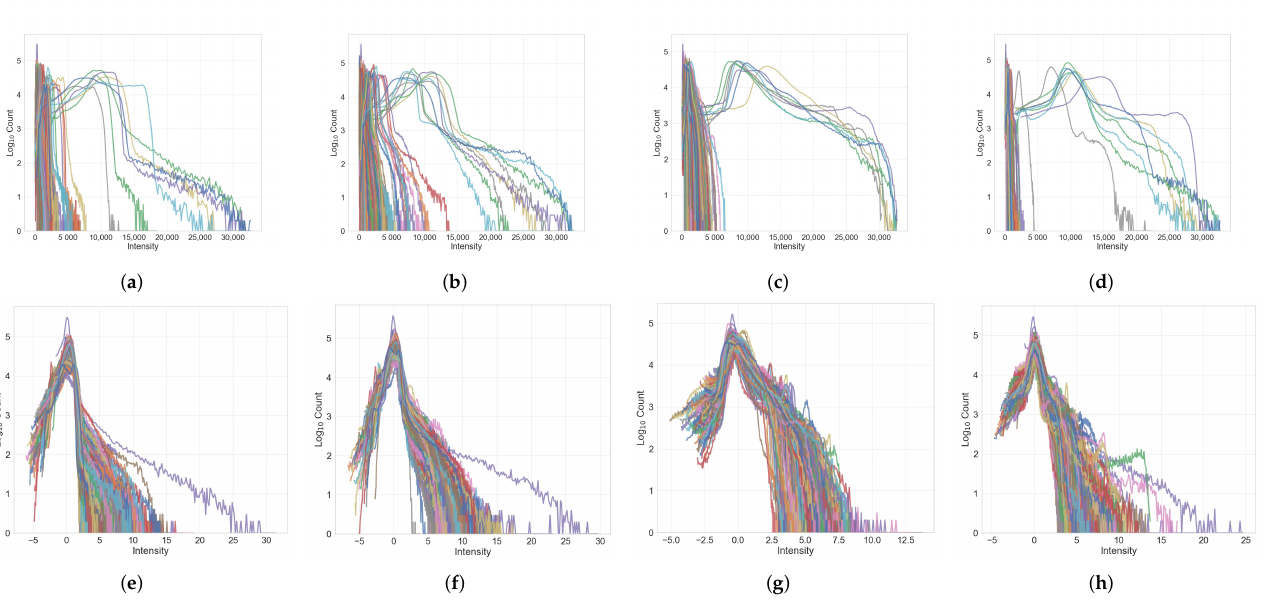
Figure A1. The intensity histograms of the original images (first row) and the Z-score normalized images (second row) for the four sequences of the MRI images. Each colored line corresponds to an image histogram of one preprocessed brain MRI image downloaded from the TCGA-GBM or TCGA- LGG dataset. The subfigures correspond to the image histograms of ( a ) original T1 MRI, ( b ) original T1Gd MRI, ( c ) original T2 MRI, ( d ) original T2-FLAIR MRI, ( e ) Z-score normalized T1 MRI, ( f ) Z-score normalized T1Gd MRI, ( g ) Z-score normalized T2 MRI, and ( h ) Z-score normalized T2-FLAIR MRI images. Obviously, the Z-score normalized images have more consistent image